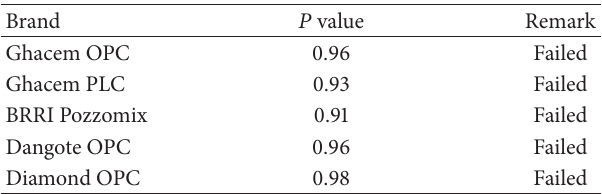
Table 2: Predictive values and remarks of Student’s 𝑡 -test between average and various cement